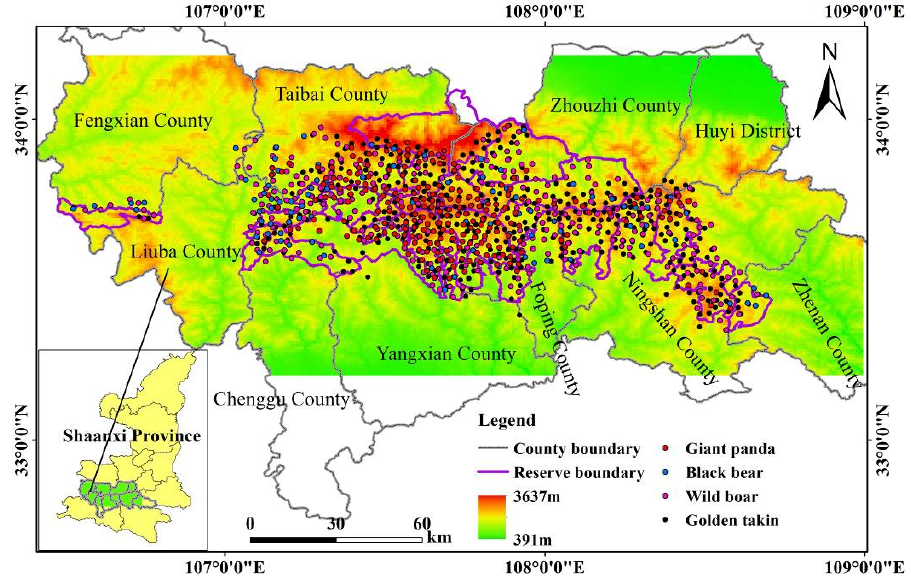
Figure 1. Location and elevation gradient of the study area in the Qinling Mountains in Shaanxi Province, China. The species occurrence points used in the study are displayed as points with different colors.